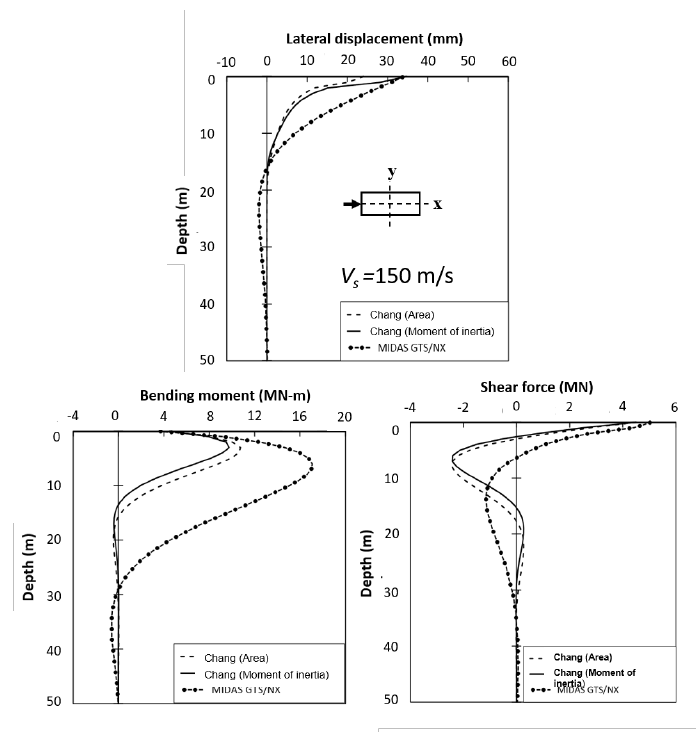
Fig. 20. Performance of barrette in clays with load applied in longitudinal